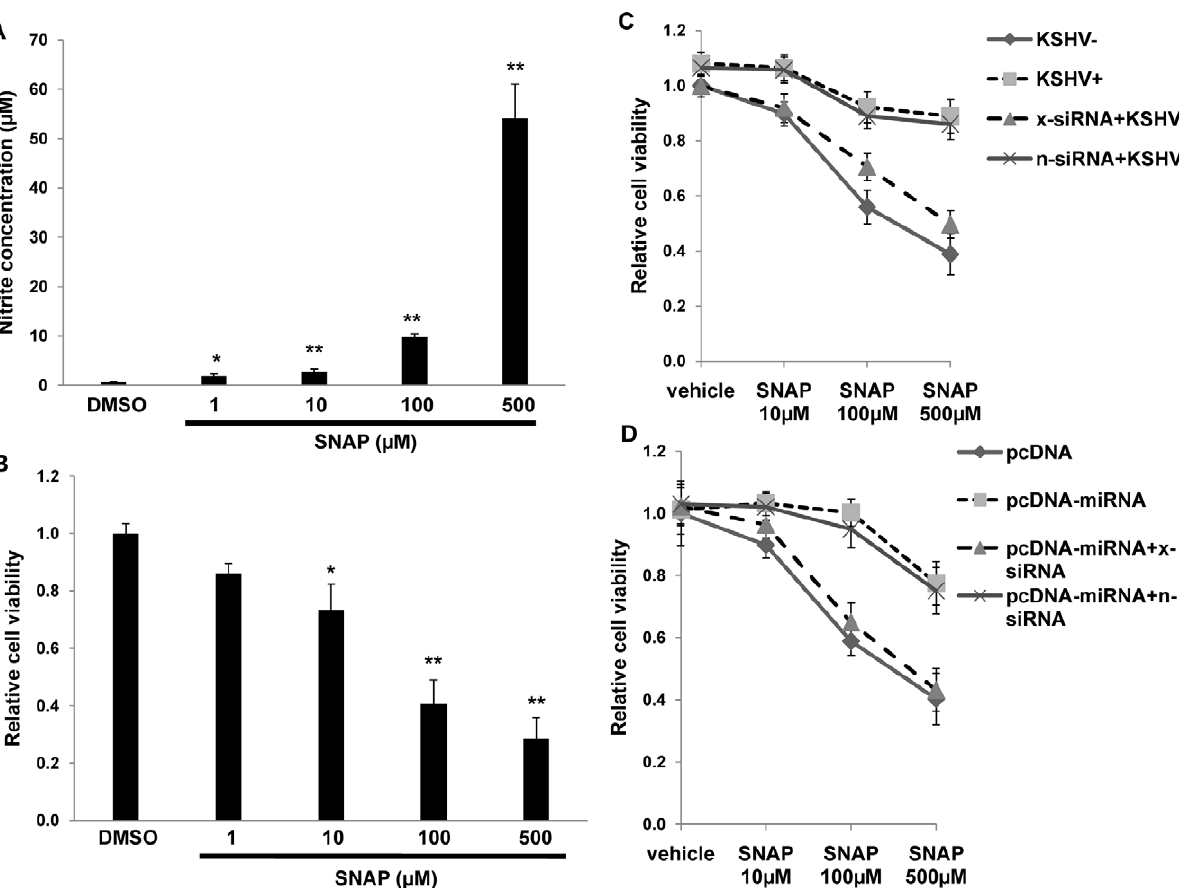
Figure 7. KSHV miRNAs enhance macrophage survival in an environment of oxidative stress through the upregulation of xCT. ( A ) RAW cells were treated with the indicated concentrations of SNAP or vehicle control for 12 h prior to nitrite quantification within culture supernatants. ( B ) Relative cell viability was determined for groups in (A) as described in Methods. ( C ) Cells were transfected with either control (n) or xCT-specific (x) siRNA and incubated with UV-K (KSHV 2 ) or KSHV (KSHV + ) 48 h later. ( D ) Cells were co-transfected with xCT siRNA and either control or miRNA-expressing vectors for 48 h, then incubated for an additional 12 h with SNAP prior to viability determinations. For all assays, error bars represent the S.E.M. for three independent experiments. *=p , 0.05, * *=p ,